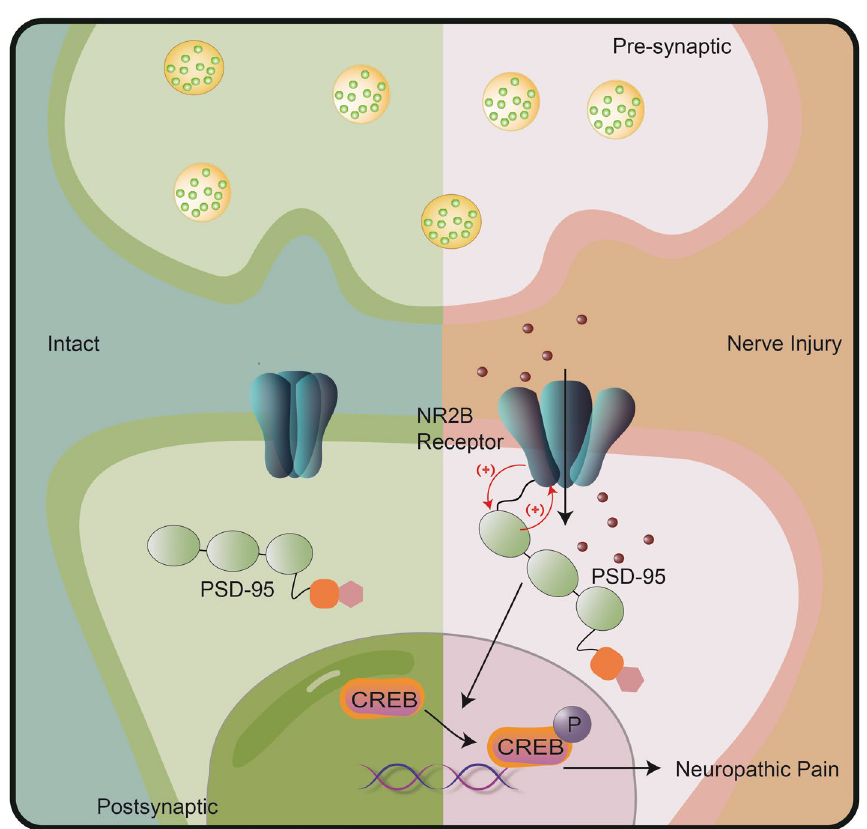
Figure 6. A schematic presentation of PSD-95 in the anterior cingulate cortex contributes to neuropathic pain by interdependent activation with NR2B. The material of the schematic diagram is provided by